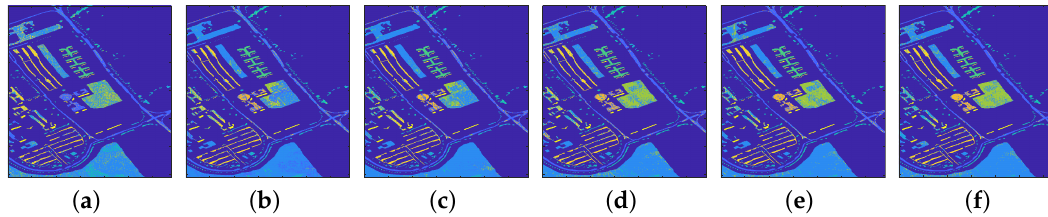
Figure 9. Overall classification accuracies of using the bands selected by different BS methods from the Pavia University dataset. ( a ) SVM ( b ) KNN.